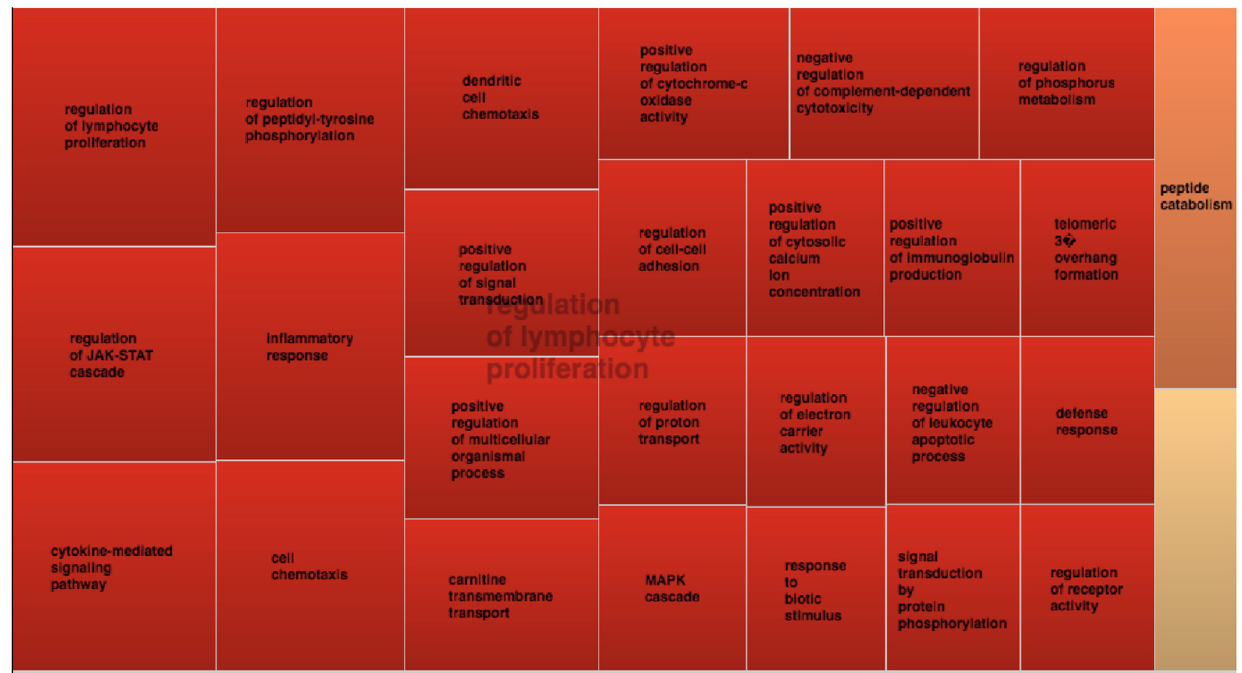
Fig 3. Treemap showing results from REVIGO analysis of gene ontology data derived from analysis of genes within the TADs that incorporate 25 JIA risk loci. Results are from K562 cells. Each rectangle of the treemap indicates a GO terms cluster. Subclusters (related GO terms) of same color are joined into super-clusters marked by centralized semi-transparent text. The size of a rectangle reflects statistical significance p-values of GO terms, with larger rectangles assigned to terms with smaller